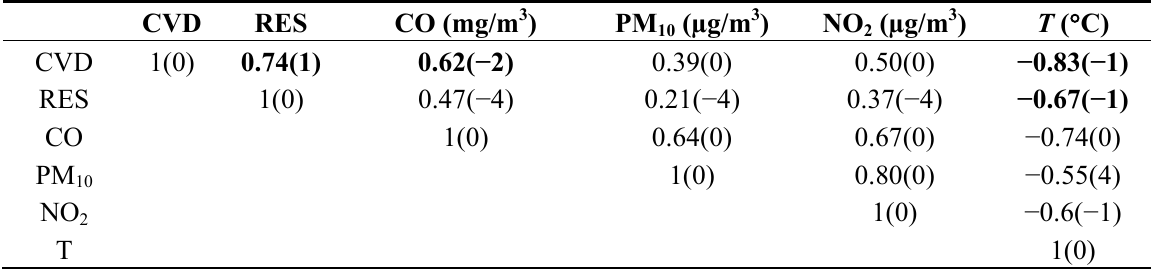
Table 3. Cross-correlation of weekly mortality, major pollutant concentrations and temperature with the associated time lag (in weeks) shown in